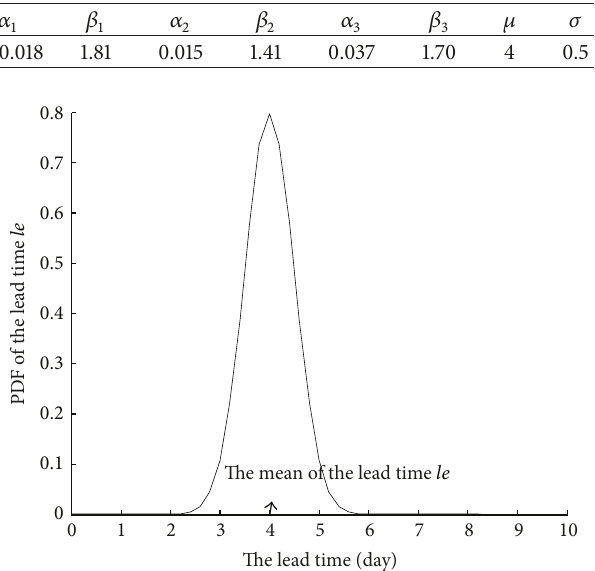
Figure 12: The PDF of the lead time 𝑙 𝑒 .